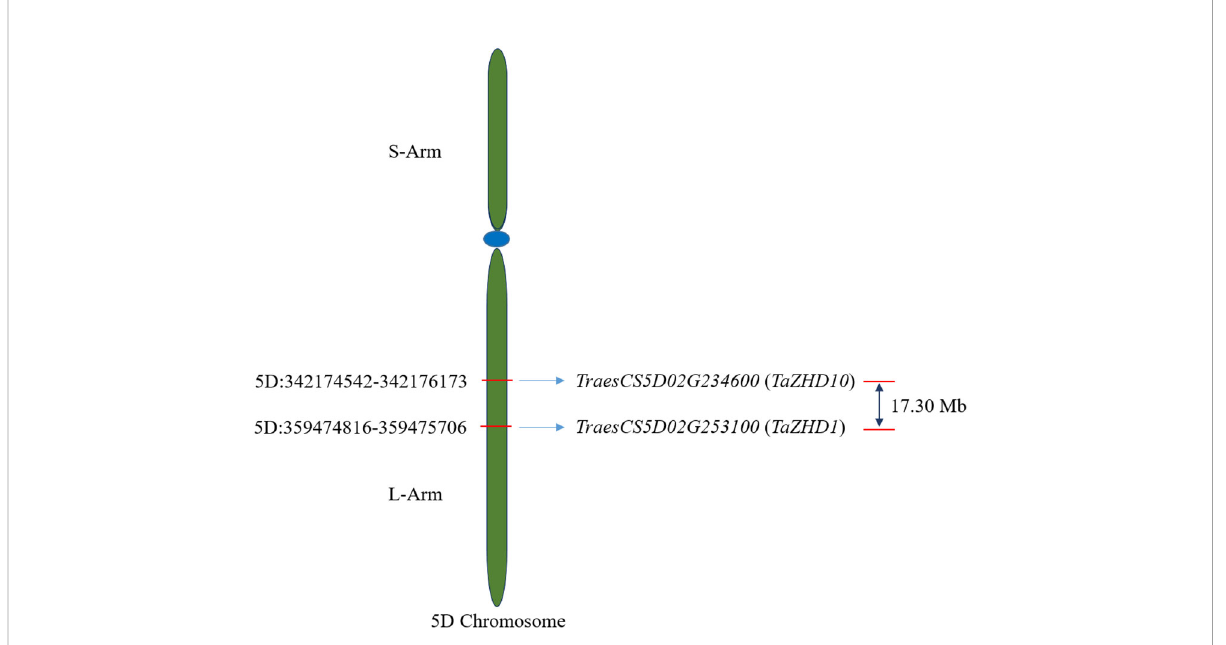
FIGURE 3 Chromosomal distribution of identi fi ed candidate ZHD genes in